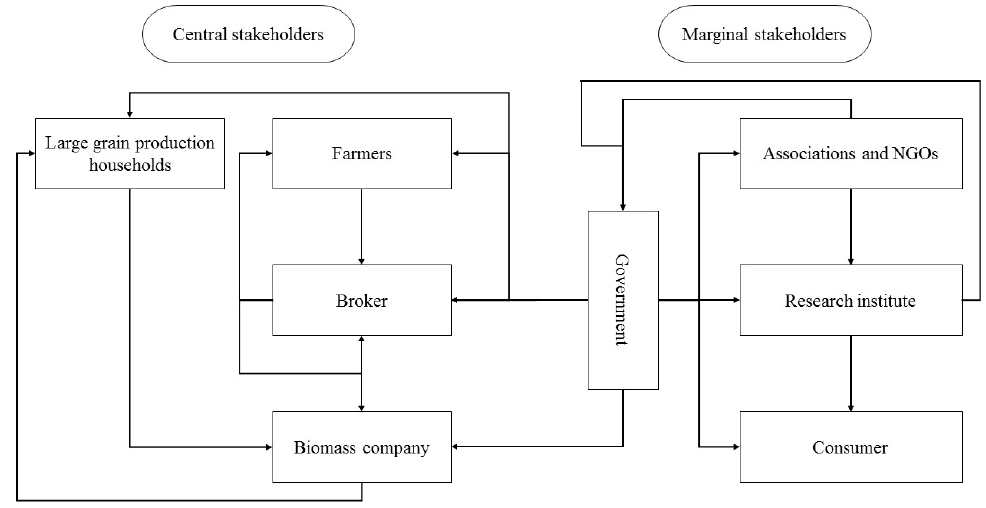
Figure 4. Social network of bioenergy stakeholders.